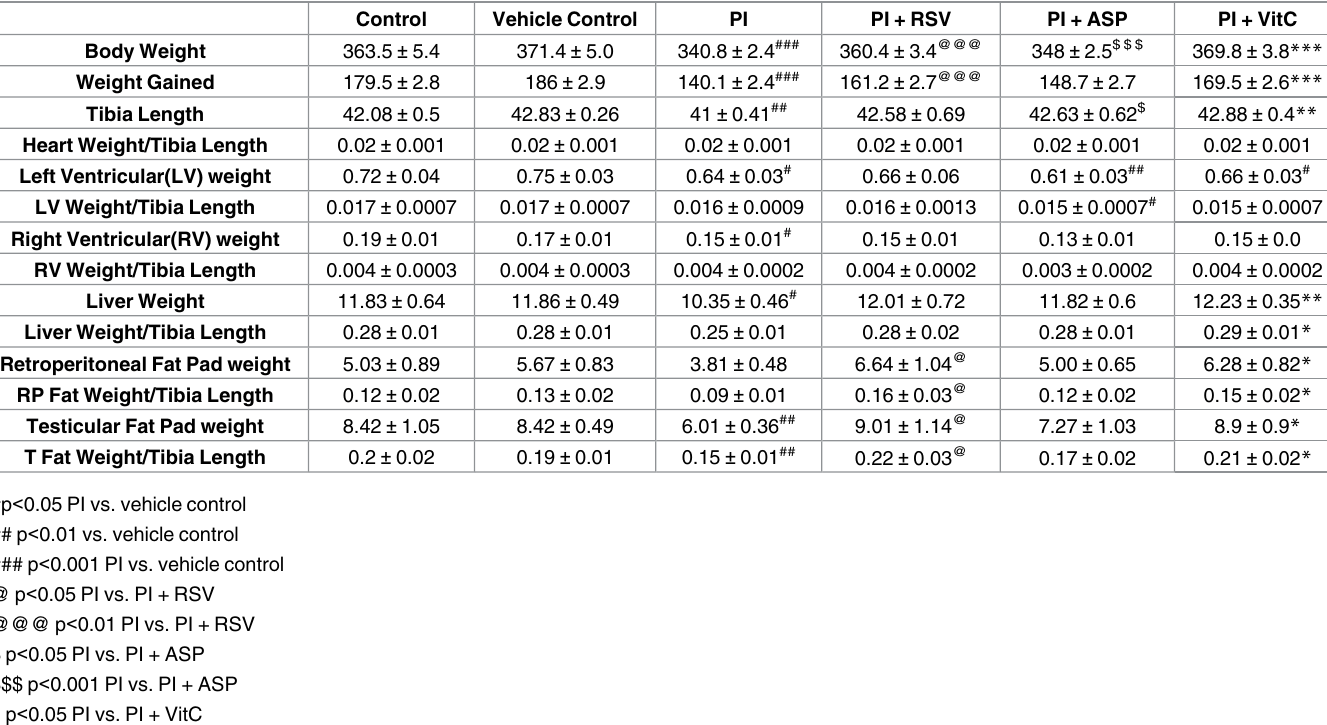
Table 1. Morphometric Changes following 4 Months of